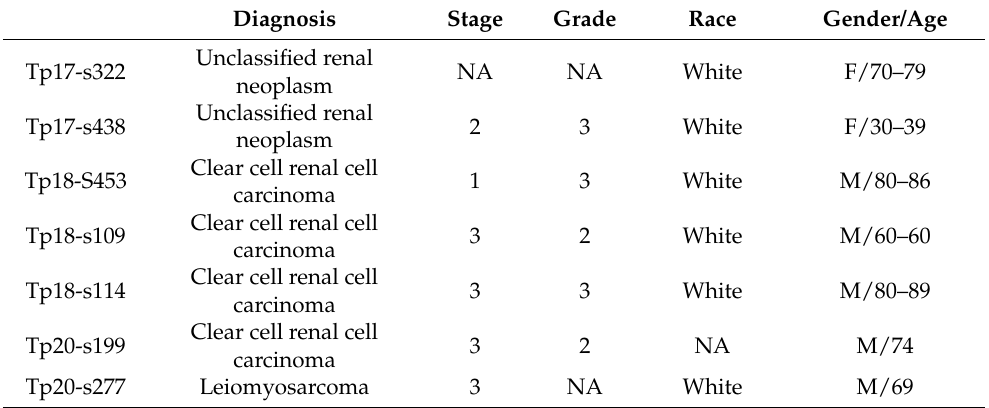
Table 1. Tissue samples used in this study. NA = not